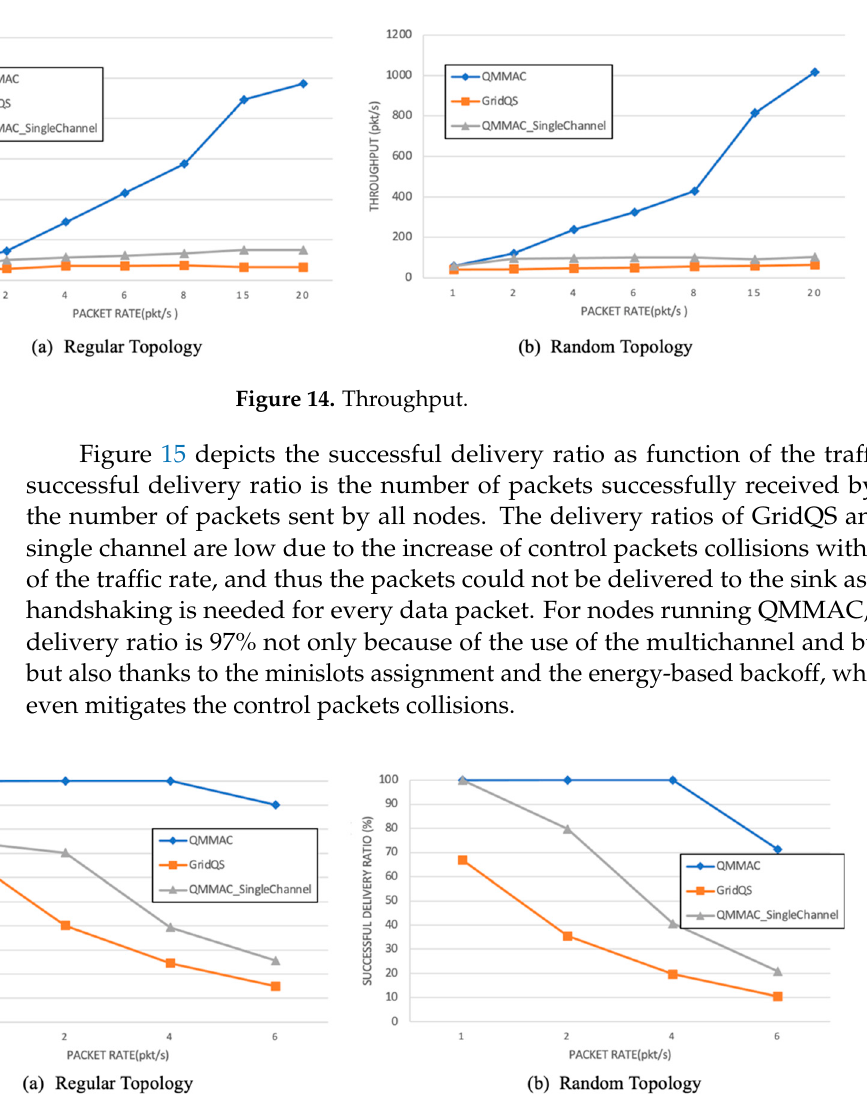
Figure 15. Successful delivery ratio.